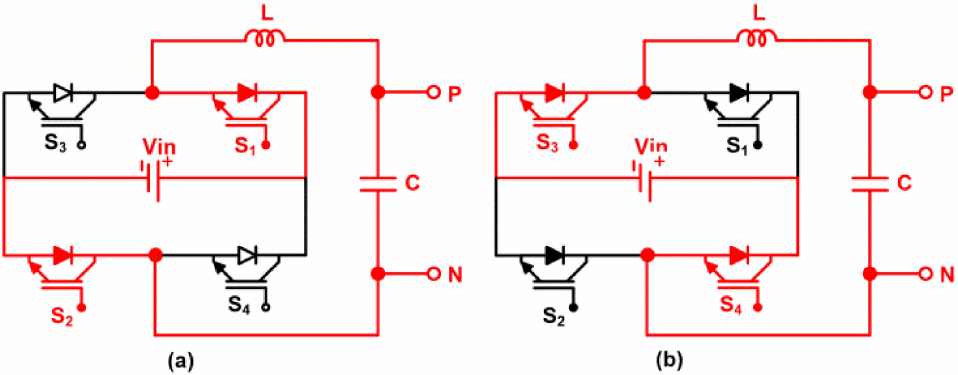
Figure 3. Modes of operation ( a ) S 1 , S 2 in ON state and ( b ) S 3 , S 4 in ON state.